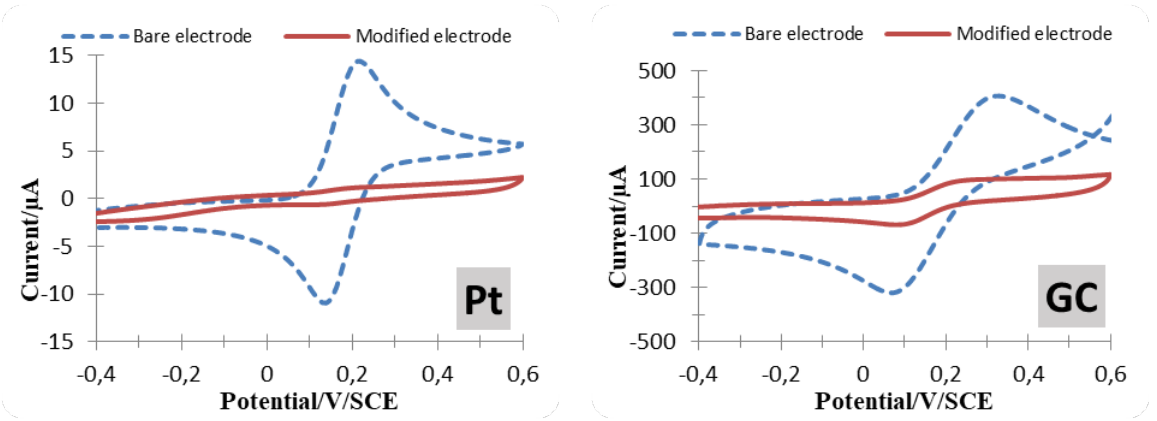
[Fe(CN) ] aqueous 3 6